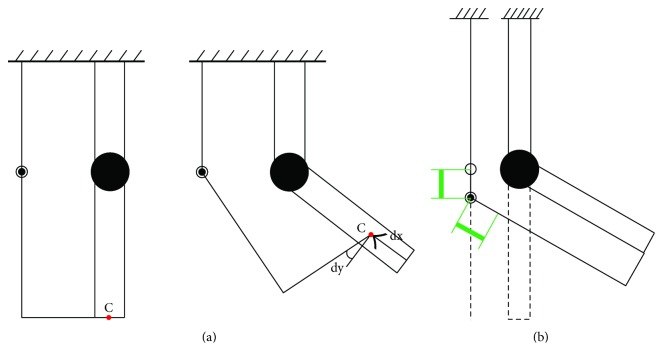
Human-robot interaction in the case of a single DOF human and exoskeleton joint.